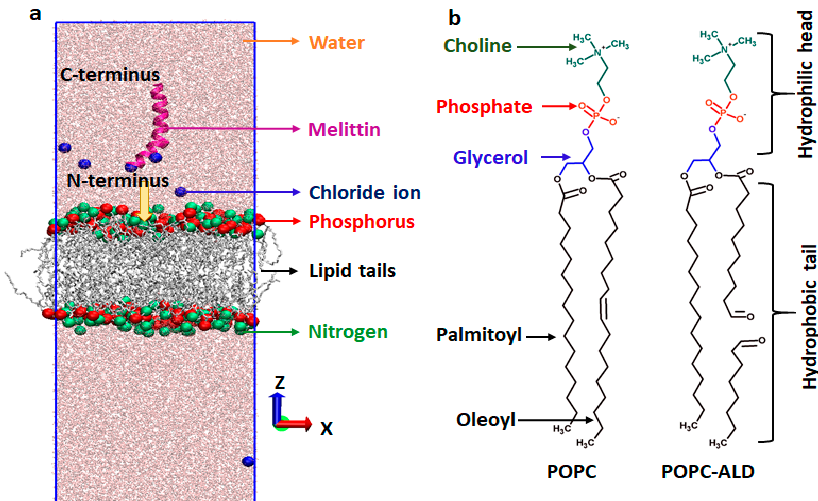
Figure 2. ( a ) Intact (or native) palmitoyl-oleoyl-phosphatidylcholine phospholipid bilayers (POPC PLB), together with melittin (MEL) in the water region. For the sake of clarity, the N and P atoms of POPC are shown with bigger beads and the lipid tails are in grey. The yellow arrow indicates the pulling direction of MEL. ( b ) Schematic illustration of native (POPC) and oxidized (into aldehyde; POPC-ALD) phospholipids. The head group consists of choline, phosphate and glycerol, whereas the lipid tails are two fatty acid chains.